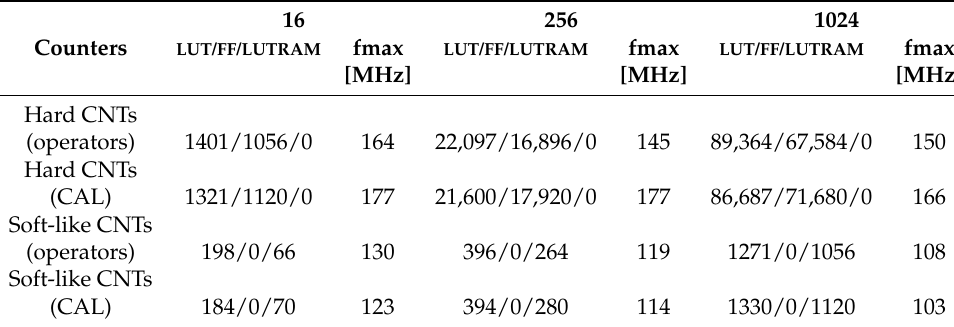
Table 3. Direct comparison of designed counter